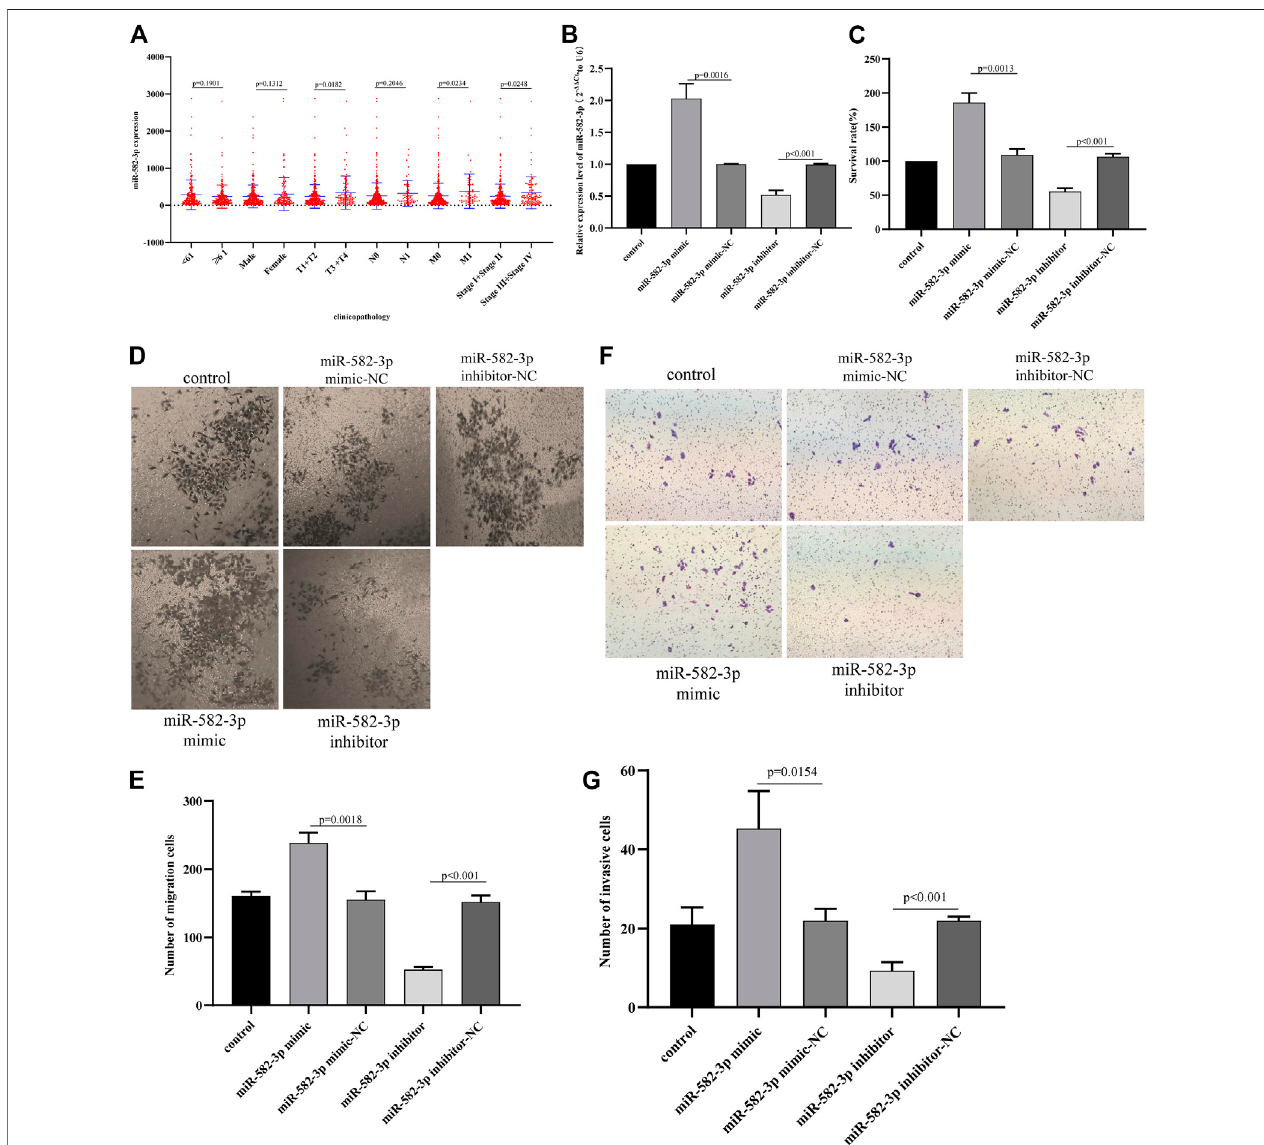
FIGURE 6 | (A) Correlation between miR-582-3p expression and clinicopathological characteristics of hepatocellular carcinoma. (B) Changes in the expression of miR-582-3p in HepG2 cells after the addition of miR-582-3p mimics and inhibitor, as shown by qPCR. The data are shown as the mean ± standard deviation. (C) Analysis of the effects of miR-582-3p knockdown or overexpression on the proliferation of HepG2 cells by CCK-8 assay. (D) and (E) Analysis of the effects of miR-582- 3p knockdown or overexpression on the migration of HepG2 cells by Transwell migration assay. (F) and (G) Analysis of the effects of miR-582-3p knockdown or overexpression on the invasion of HepG2 cells by Transwell